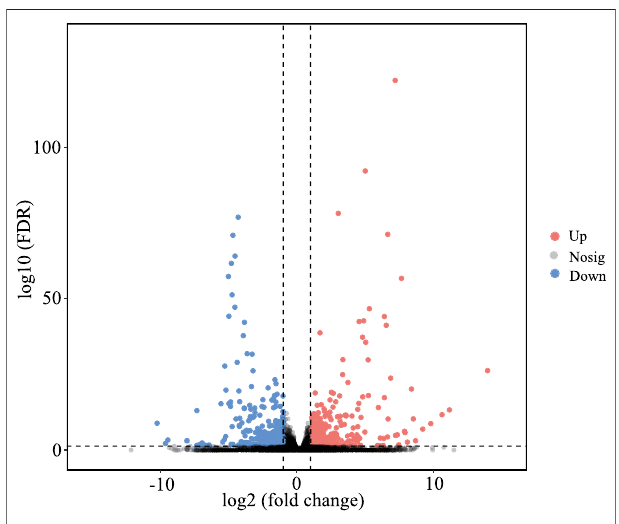
FIGURE 2 | Volcano plots of differentially expressed genes (DEGs) betweenblind-sidenormalskinandblind-sidehypermelanoticskin.FDR:false discovery